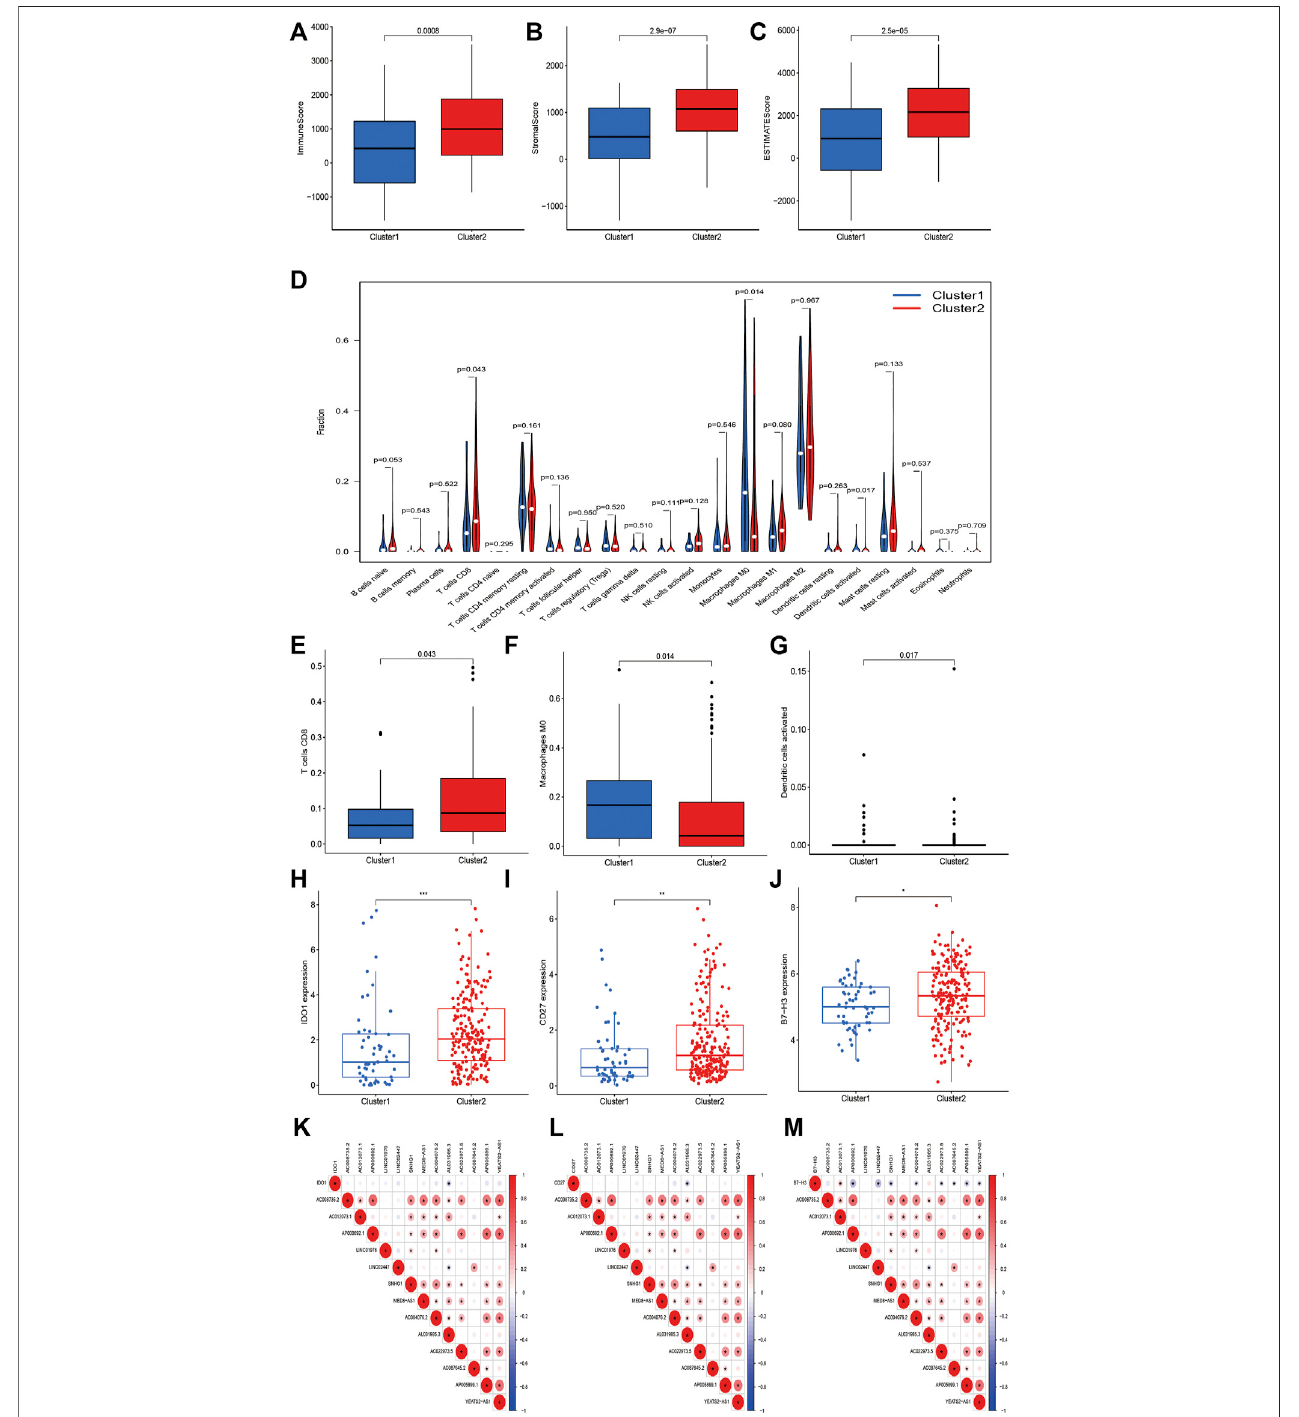
FIGURE 4 | m6A-related lncRNAs were correlated with immune landscape in STS. (A – C) Immune, stroma and ESTIMATE scores in cluster 1 and cluster 2 subgroups. (D) The abundance of 22 immune cell types in cluster 1 and cluster 2 subgroups. The abundance of (E) CD8+ T cell, (F) macrophage M0 and (G) dendritic cell activated in cluster1 and cluster 2subgroups. (H – J) The expression ofimmunecheckpoints (H) IDO1, (I) B7-H3 and (J) CD27 incluster 1 and cluster 2subgroups. (K – M) Co-expression analysis of immune checkpoints and 13 m6A-related lncRNAs.